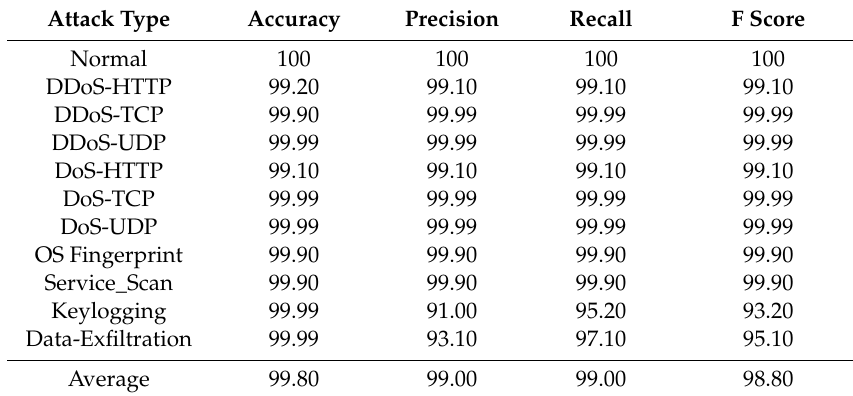
Table 12. Accuracy, Precision, Recall, and F Score for 10-Fold Cross-Validation. Attack Type